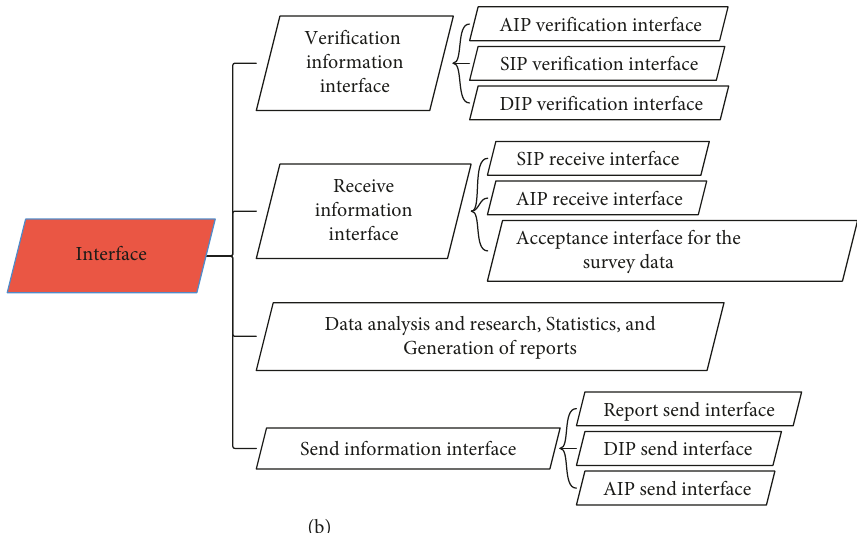
Figure 8: Logical layer structure: (a) the sending flow chart of the logic layer and (b) interface diagram of the logical layer.